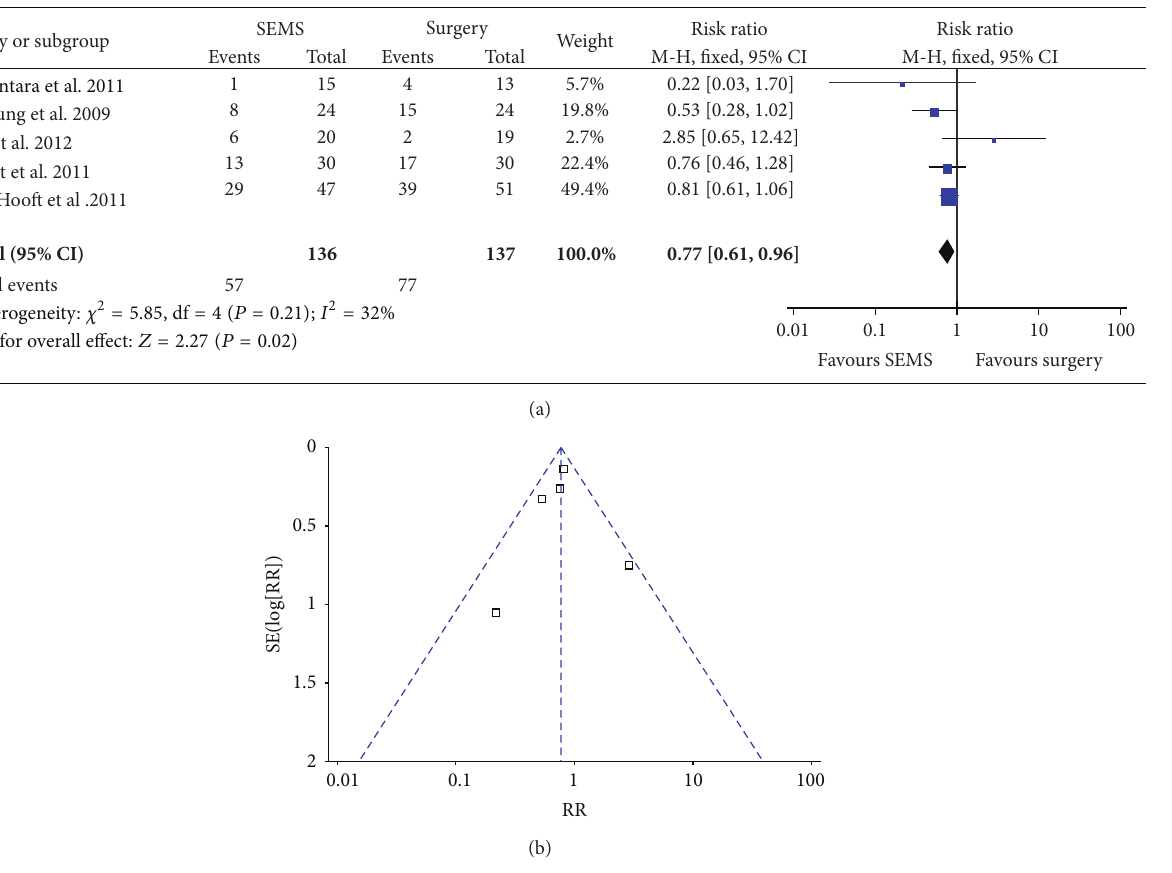
Figure 3: Forest plot and funnel plot of overall colostomy rate. Table 6: Sensitivity test for meta-analysis of overall complication rate of semi-elective surgery after SEMS installation versus emergency surgery.